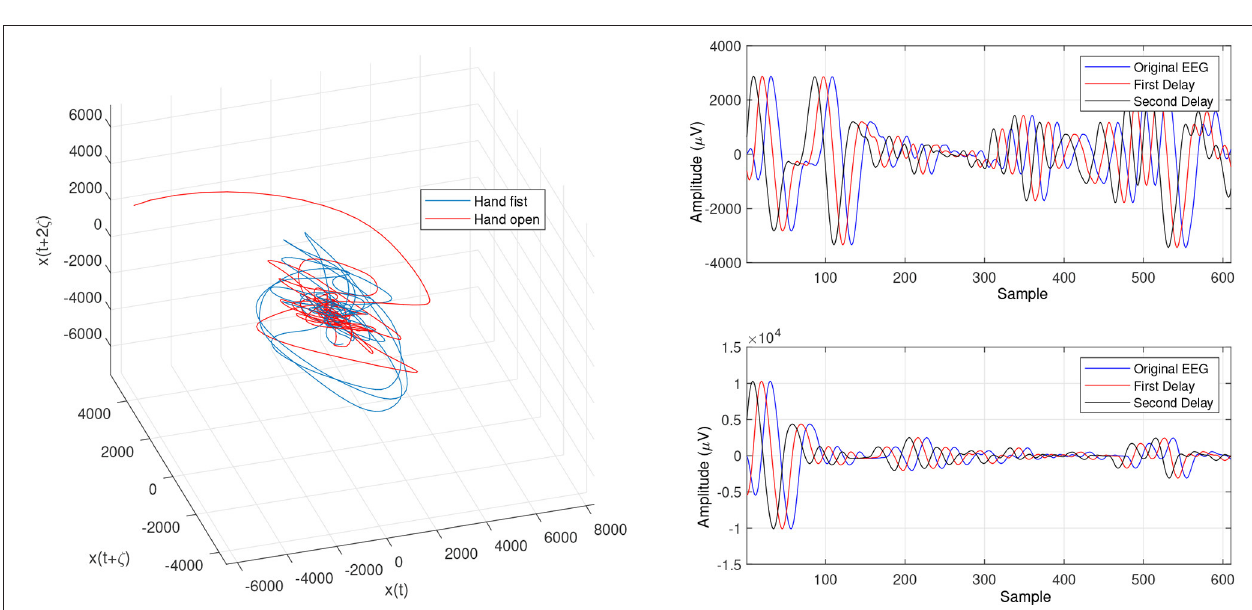
FIGURE 6 | Trajectories of hand open and making a fist by using the optimized LLE (OLLE) in the reconstructed phase space based on the WD for channel C3.